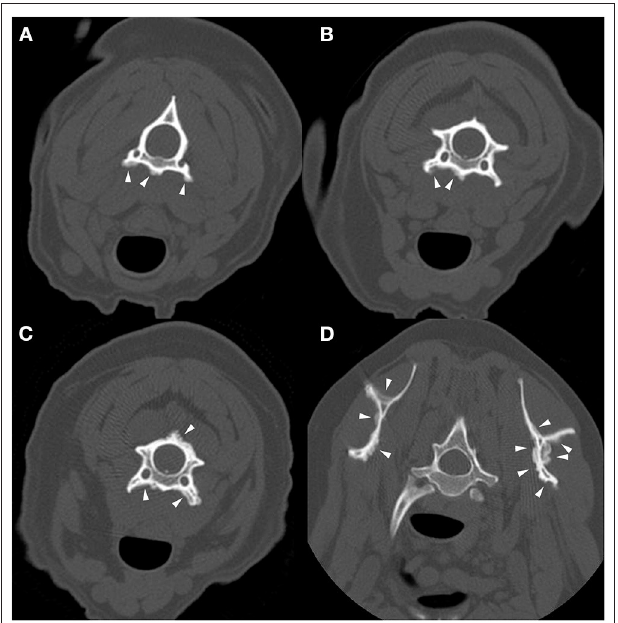
FIGURE 4 | Example of suspected lesions of American canine hepatozoonosis. Non-contrast transverse images of the fifth (A) , sixth (B) , and seventh lumbar vertebrae (C) and a sagittal image of the caudal lumbar vertebrae (D) in a 7 year-old male neutered Yorkshire terrier dog that tested positive for Hepatozoon americanum polymerase chain reaction. In all images, there is multifocal, irregularly marginated, periosteal proliferation on several non-articular surfaces of the lumbar vertebrae (white arrowheads). There is no lysis of cortical bone in any image. In (A) , the lesions are restricted to the ventral vertebral body and transverse process. The periosteal proliferation is thick and forms a nearly continuous pseudocortex. The lesions in (B) are similar to (A) , but highlight the asymmetry of the lesions. In (C) , the pseudocortex is undulant and disappears axially. The periosteal proliferation is lateralized and equally prominent on the left pedicle of the sixth lumbar vertebra. In (D) , smooth periosteal proliferation is present at the midventral vertebral body of the fourth and fifth lumbar vertebrae. The periosteal proliferation is widest at the middle of the vertebral body and tapers toward the intervertebral disc space. There is no bridging periosteal